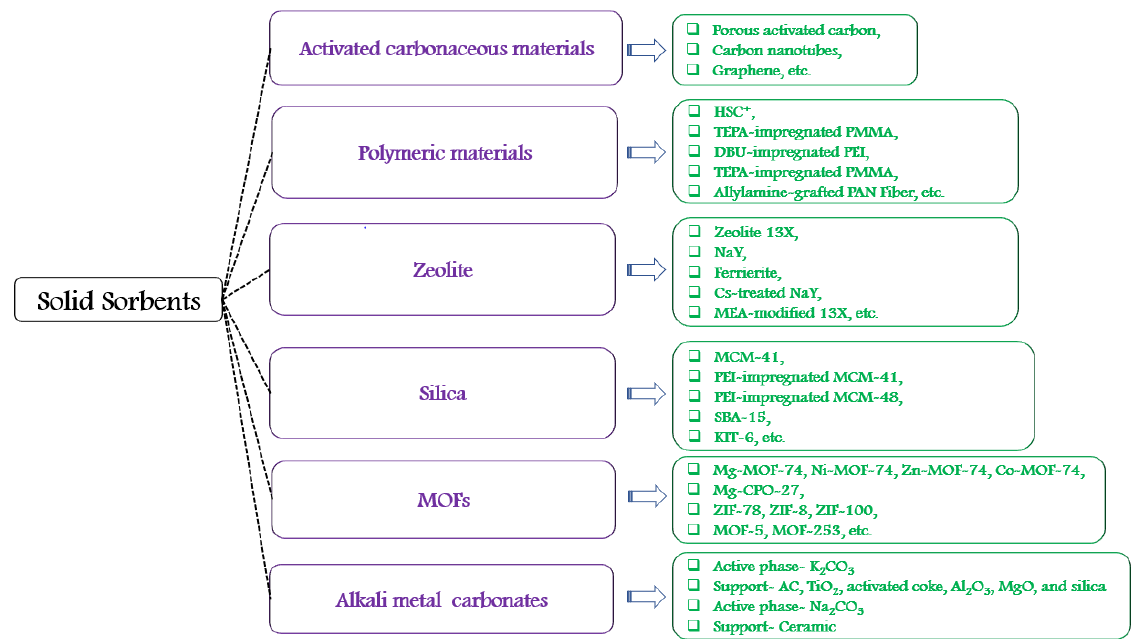
Figure 7. The families of solid sorbents.